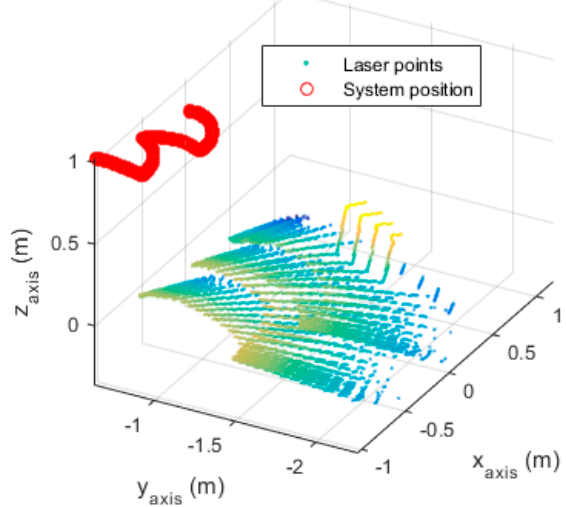
Figure 11. Results of the dynamic experiment.